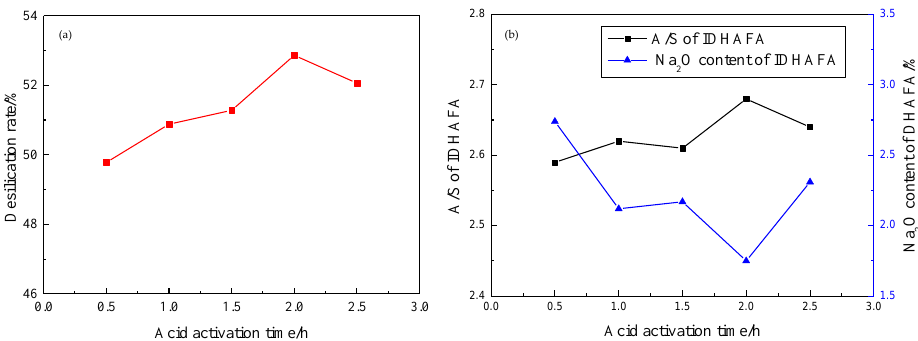
Figure 4. Effect of acid activation time ( T = 95 °C): ( a ) desilication rate, ( b ) A/S and Na 2 O of IDHAFA.